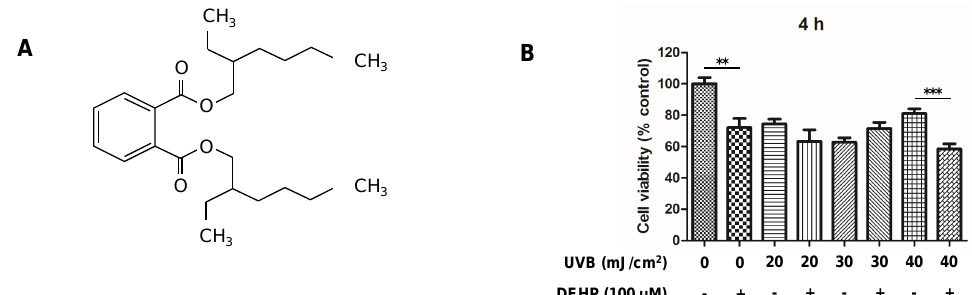
Figure 1. Chemical structure of DEHP ( A ), cell viability in DEHP-treated HaCaT cells challenged with UV-B irradiation at the indicated intensities ( B ). Confluent HaCaT cells were pre-treated with 100 µ M DEHP prior to incubation for 4 h with 40 mJ/cm 2 UV-B. Cell viability was measured using MTT assay and presented as means ± SEM from three independent experiments with multiple estimations. ** p < 0.01; *** p < 0.001 vs. control